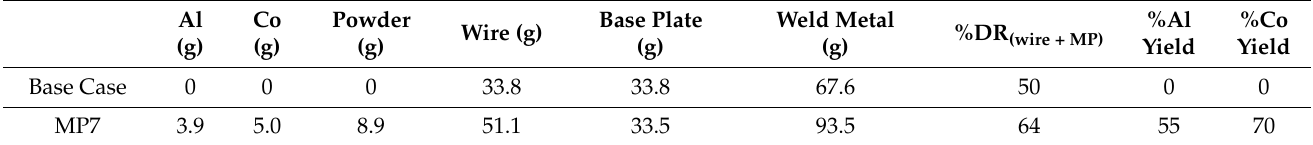
Table 5. Mass balance numbers for percentage yield calculation.